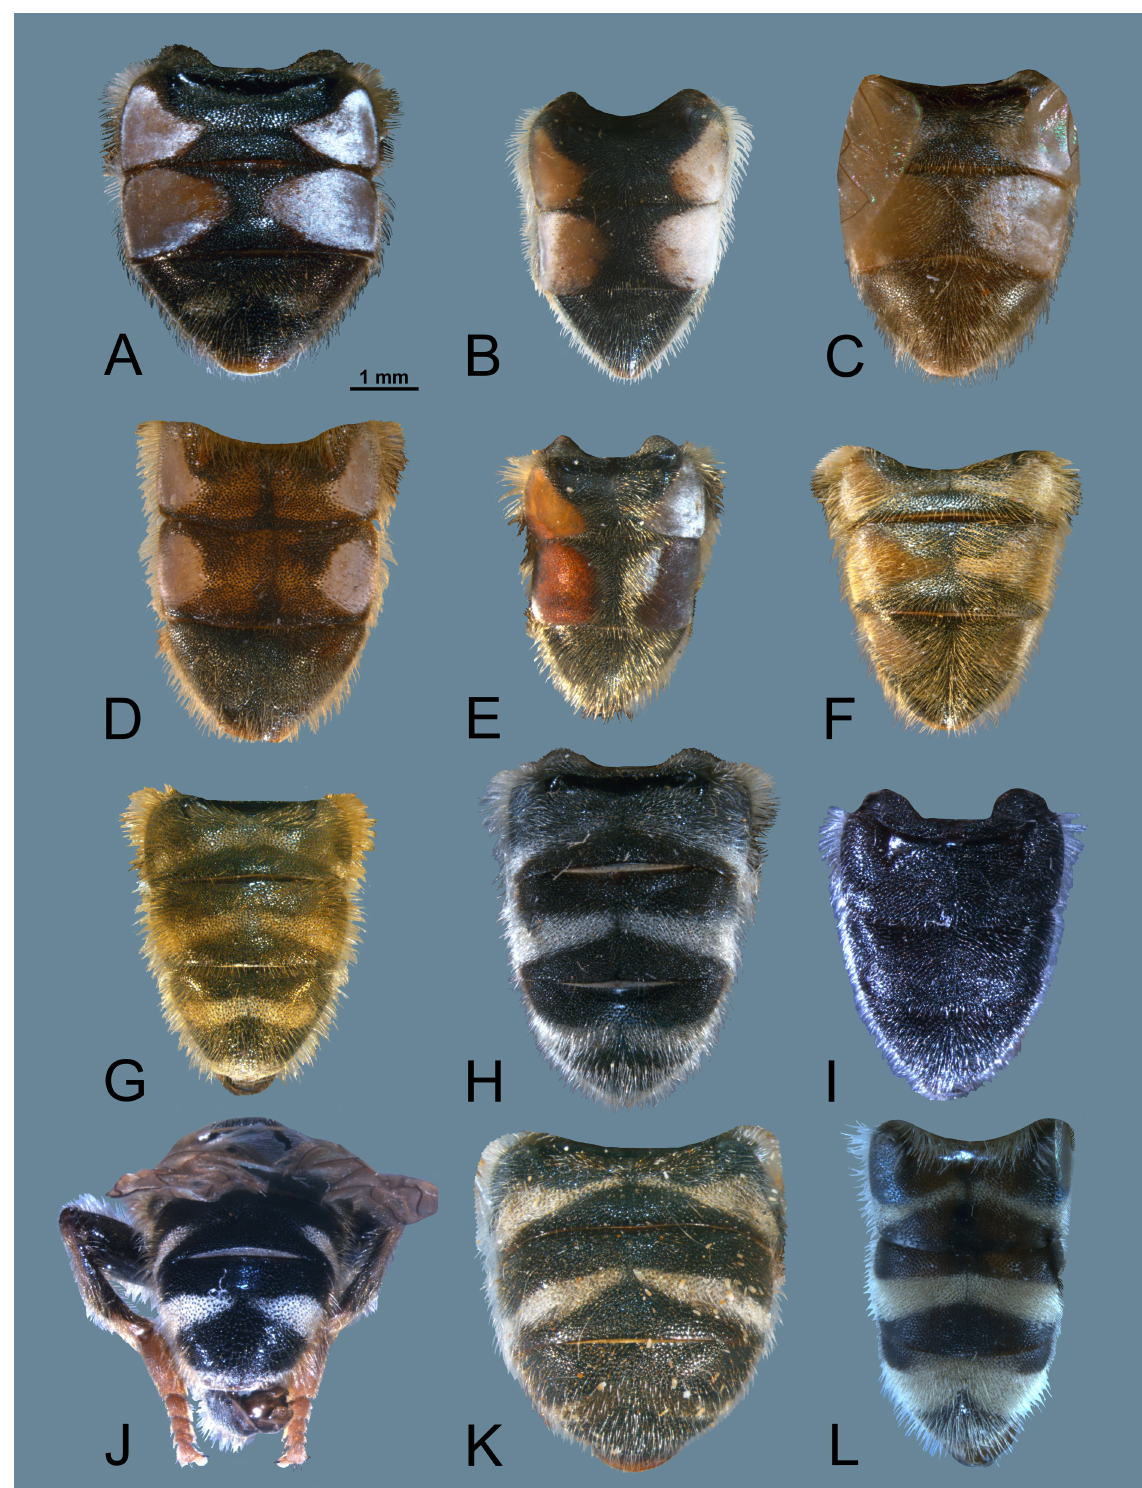
Fig. 7. Megatrigon spp., abdomen, dorsal view, ♂. A . Megatrigon argenteus (Walker, 1852) comb.